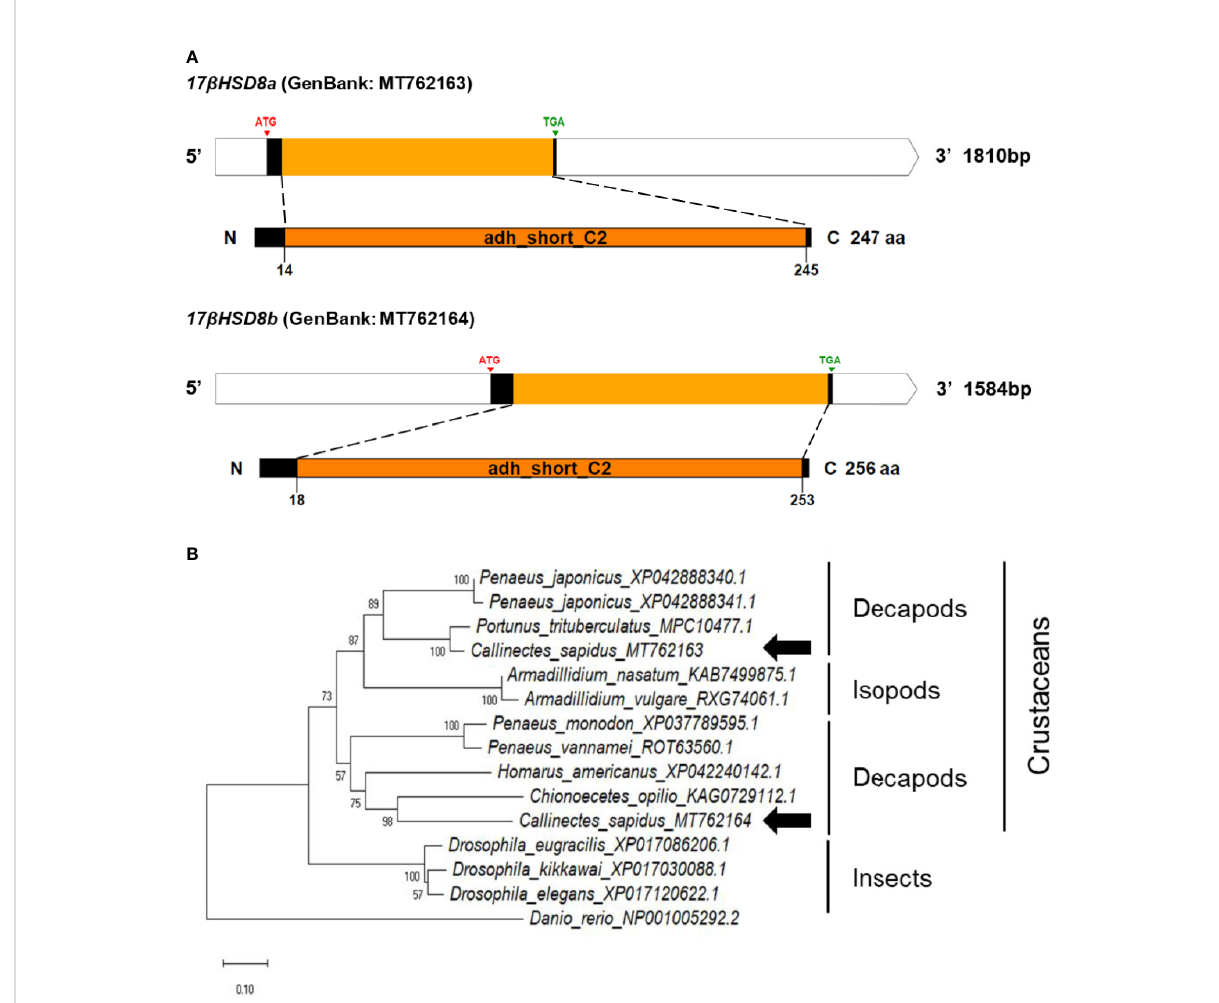
FIGURE 5 (A) Schematic representation of C. sapidus 17 b HSD8 . The conserved domains of 17 b HSD proteins are marked in orange (adh_short_C2: Enoyl- (Acyl carrier protein) reductase). (B) Phylogenetic tree of 17 b HSD8 proteins was constructed using neighbor-joining (NJ) approach in MEGAX. The amino acid sequences of 17 b HSD8 of crustaceans, insects and zebra fi sh were retrieved from NCBI database. Bootstrap consisted of 1000